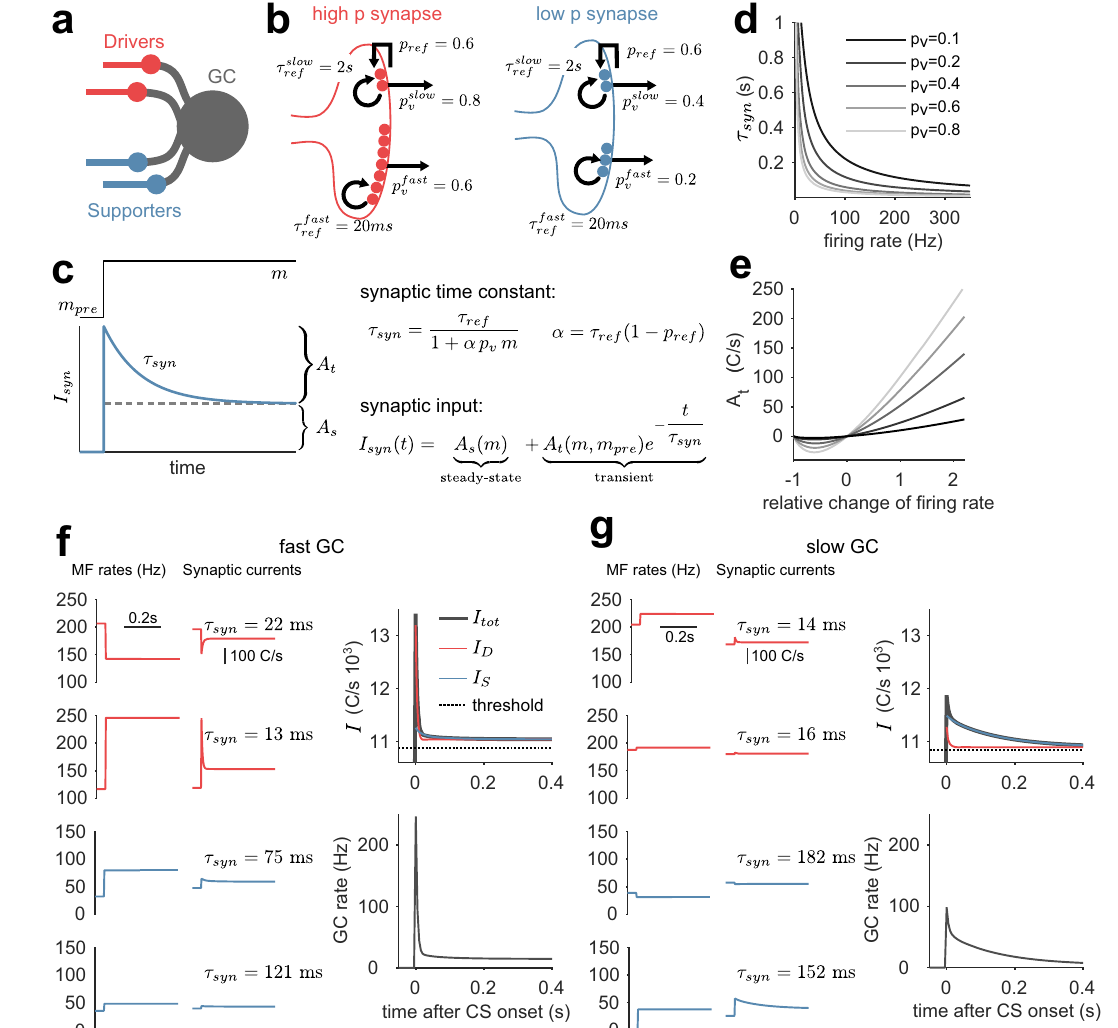
Fig.3|MF-GCsynaptictimeconstantsandtheirrelativeweightsdeterminethe time course of GC responses. a Scheme of GC inputs in the simpli fi ed synaptic model. Each GC receives exactly two distinct high release probability driver (red) and low release probability supporter MFs (blue). b Schemes of the reduced synapticmodelofhighp v (red)andlowp v synapses(blue). c Left:schemeofsingle poolresponsewiththetimeconstant τ syn (blueline)toa fi ringrateswitchduringCS presentation (black solid line). The dashed black line separates the transient (A t ) from the steady-state amplitude (A s ). Right: equations determining the synaptic time constant and synaptic input. d Slow vesicle pool time constant ( τ syn ) versus presynaptic MF fi ring rate. Different shades of gray indicate different release probabilities. e Driver synapse transient amplitude (A t ) versus relative fi ring rate